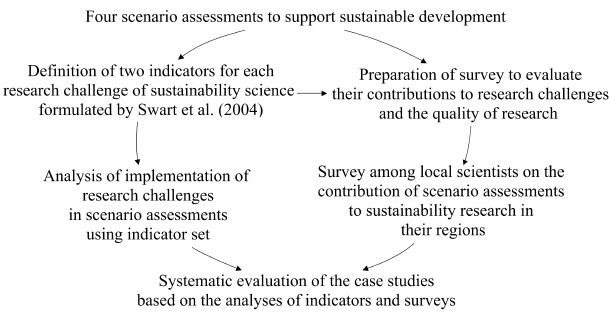
Fig. 2 . Research steps followed during this study to systematically evaluate the case studies based on different sources of materials. The left side of the circle describes the steps for analyzing scenario products and scenario process features and the right side visualizes the steps for collecting data through